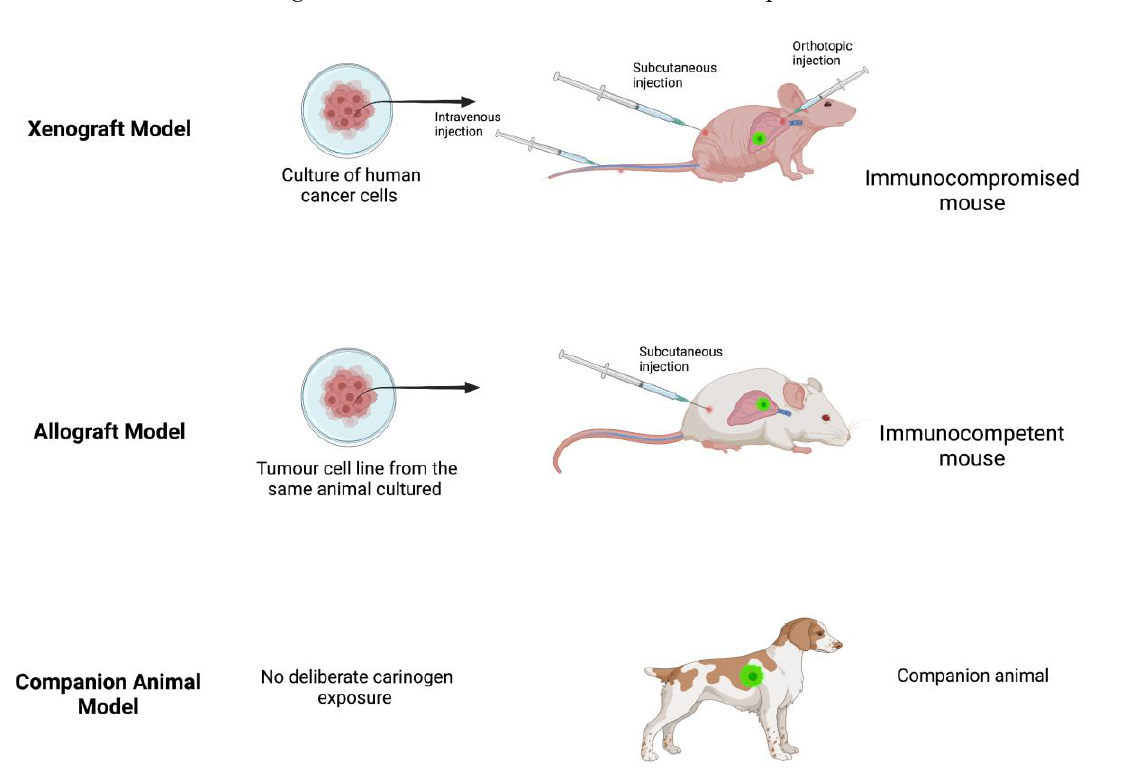
Figure 1. Examples of xenograft, allograft and companion animal models. Created with BioRen-